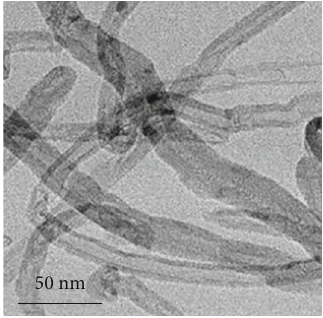
Figure 4: HRTEM image of